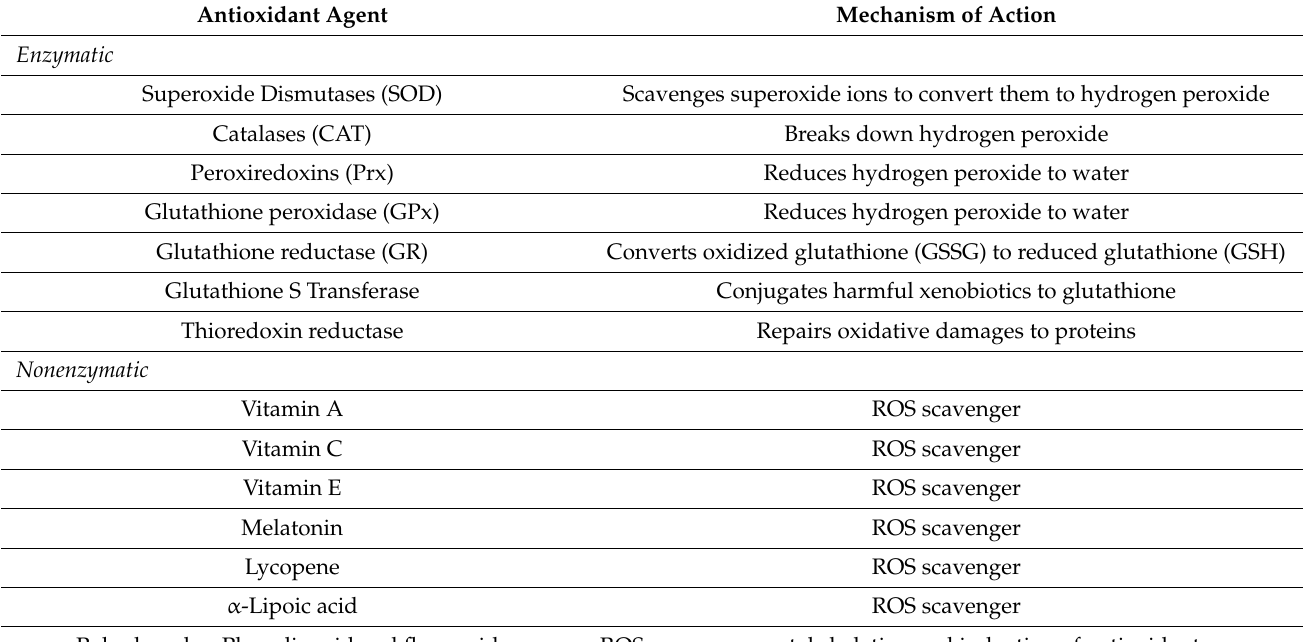
Table 3. Enzymatic and nonenzymatic antioxidant